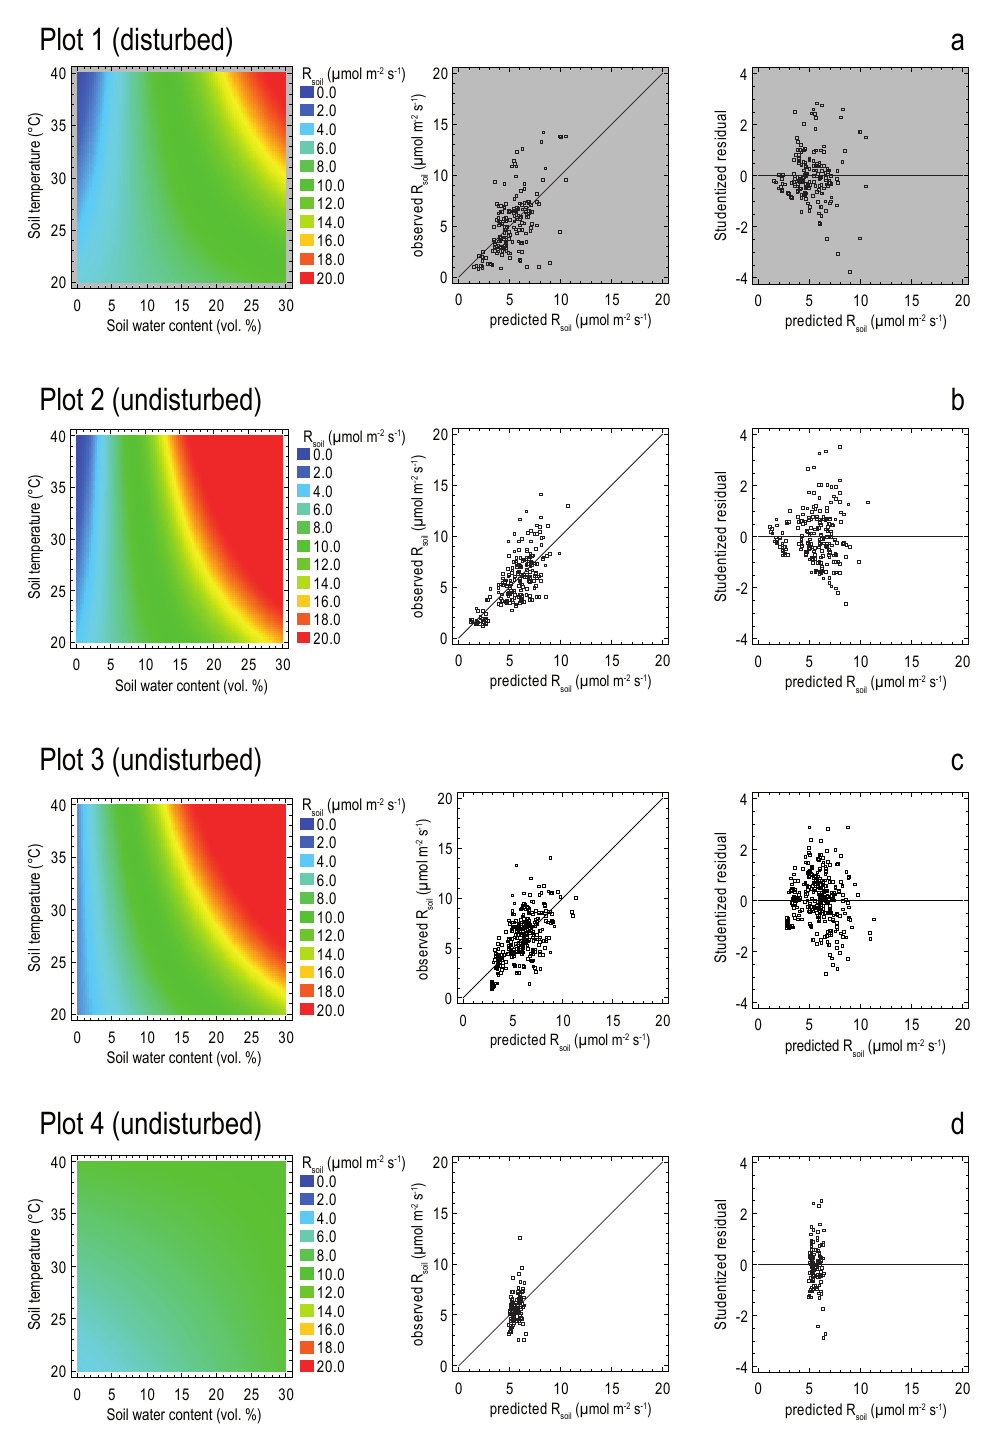
Fig. 3. General linear models explaining soil respiration using soil temperature and soil water content as predictors. Panels a–d represent the 4 inventory plots. The first column shows the response of R soil in relation to T soil and θ . The second column the predicted versus the observed respiratory values and the third column the associated residual plots. Plot 4 is slightly underrepresented due to a lack of data for the wet and dry season